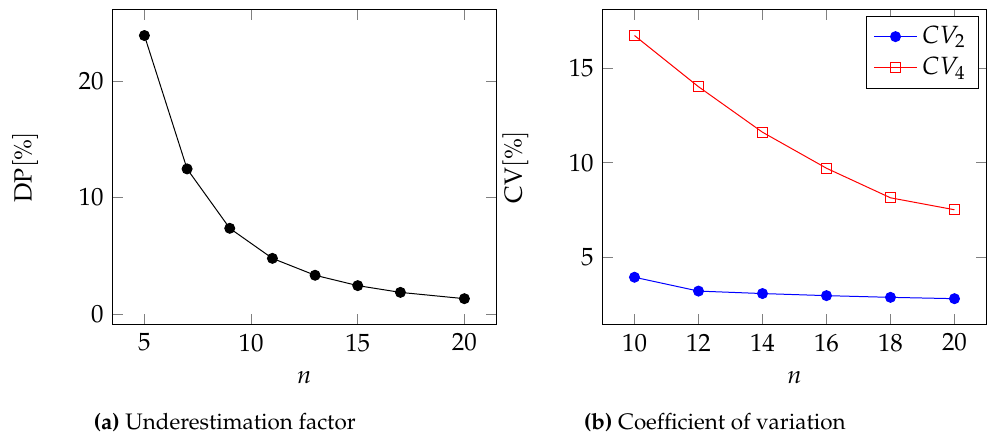
Figure 5. Performance metrics for the lognormal case (distribution parameters as in Table 5). Table 6. Underestimation DP and coefficients of variation CV in percentage for the two premium for values considered in Section 3.2 for n = 5.